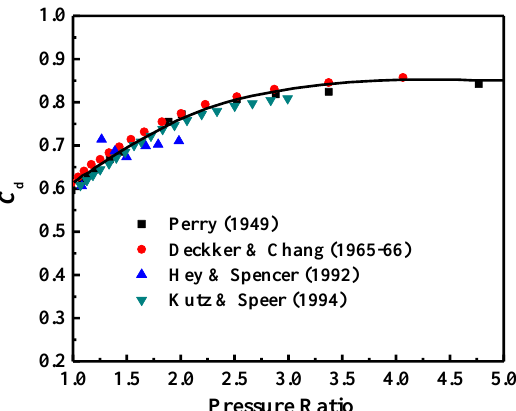
Figure 10. Influence of the leakage pressure ratio on the discharge coefficient.